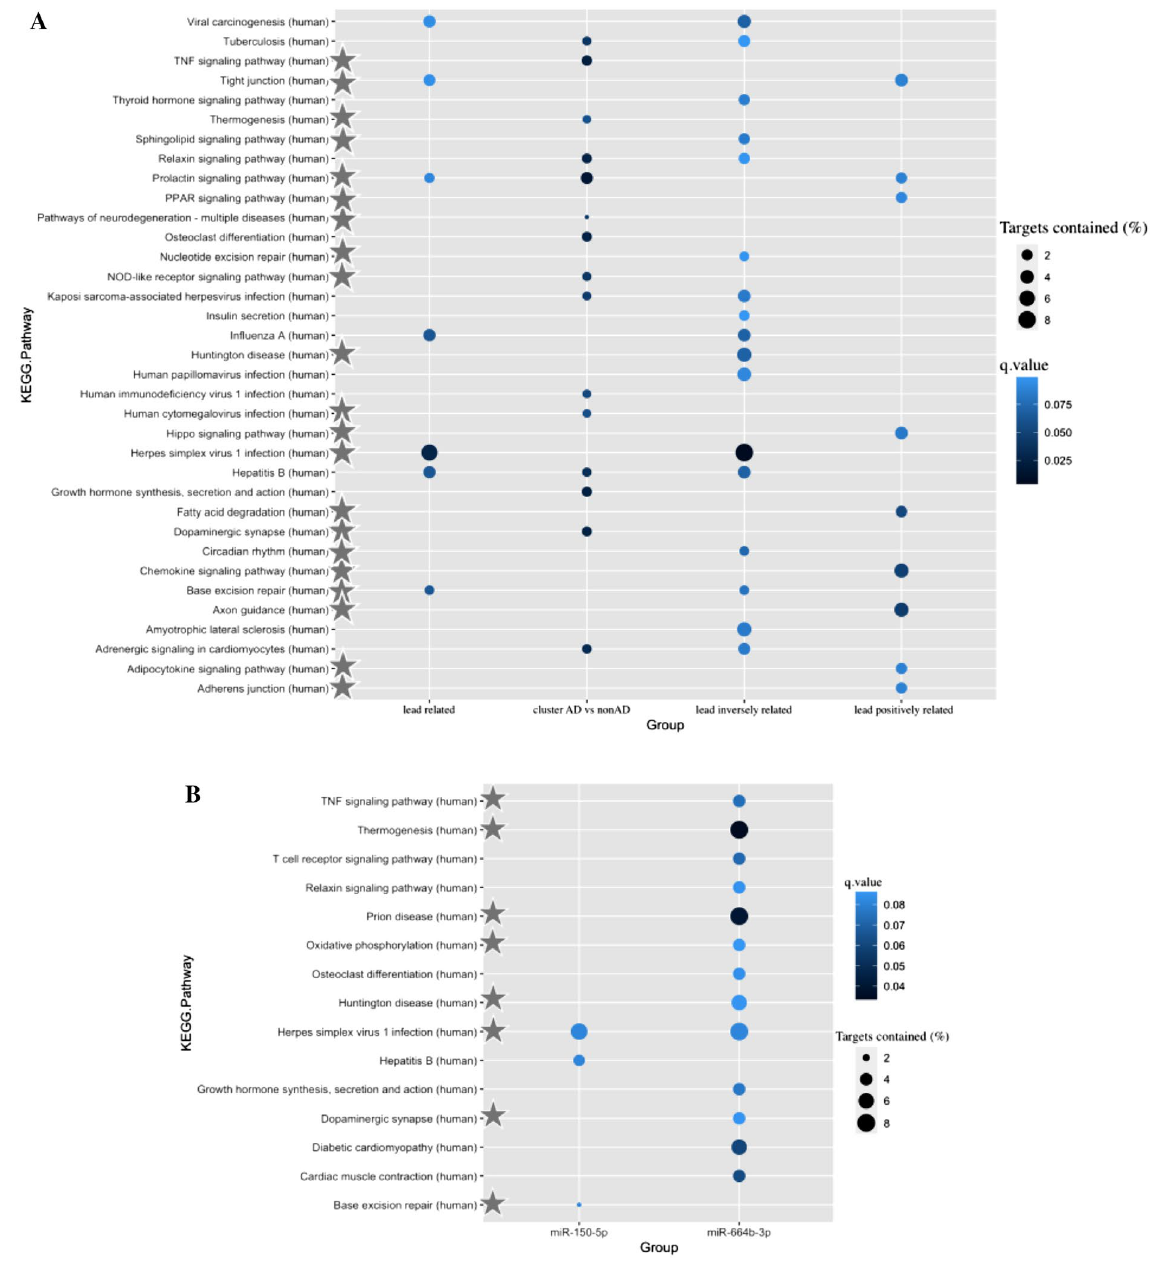
Figure 4. Bubble plot of enriched pathways from the miRNA-gene targets. ( A ) Pathways for gene targets that were expressed in human brain tissue of lead exposure associated miRNAs. The pathways marked with a star were potentially AD-related based on literature (Supplementary Table S1). The group lead related refers to all gene targets (associated with lead-affected miRNAs’ expression) enriched pathways, lead inversely related refers to inversely genes (positively related to miRNAs that were negatively related to lead exposure or negatively related to miRNAs that were positively related to lead exposure) enriched pathways, lead positively related refers to positively genes (positively related to miRNAs that were positively related to lead exposure or negatively related to miRNAs that were negatively related to lead exposure) enriched pathways, and cluster AD vs nonAD refers to pathways of 27 genes that were obtained via feature selection as described in Fig. 5; ( B ) Pathways for each miRNA’s gene targets that were associated with miRNA expression and expressed in human brain tissue. The pathways marked with star were potentially AD relevant according to literature (Supplementary Table S1). The targets of miR-3651 and miR-627 were not significantly enriched in any KEGG